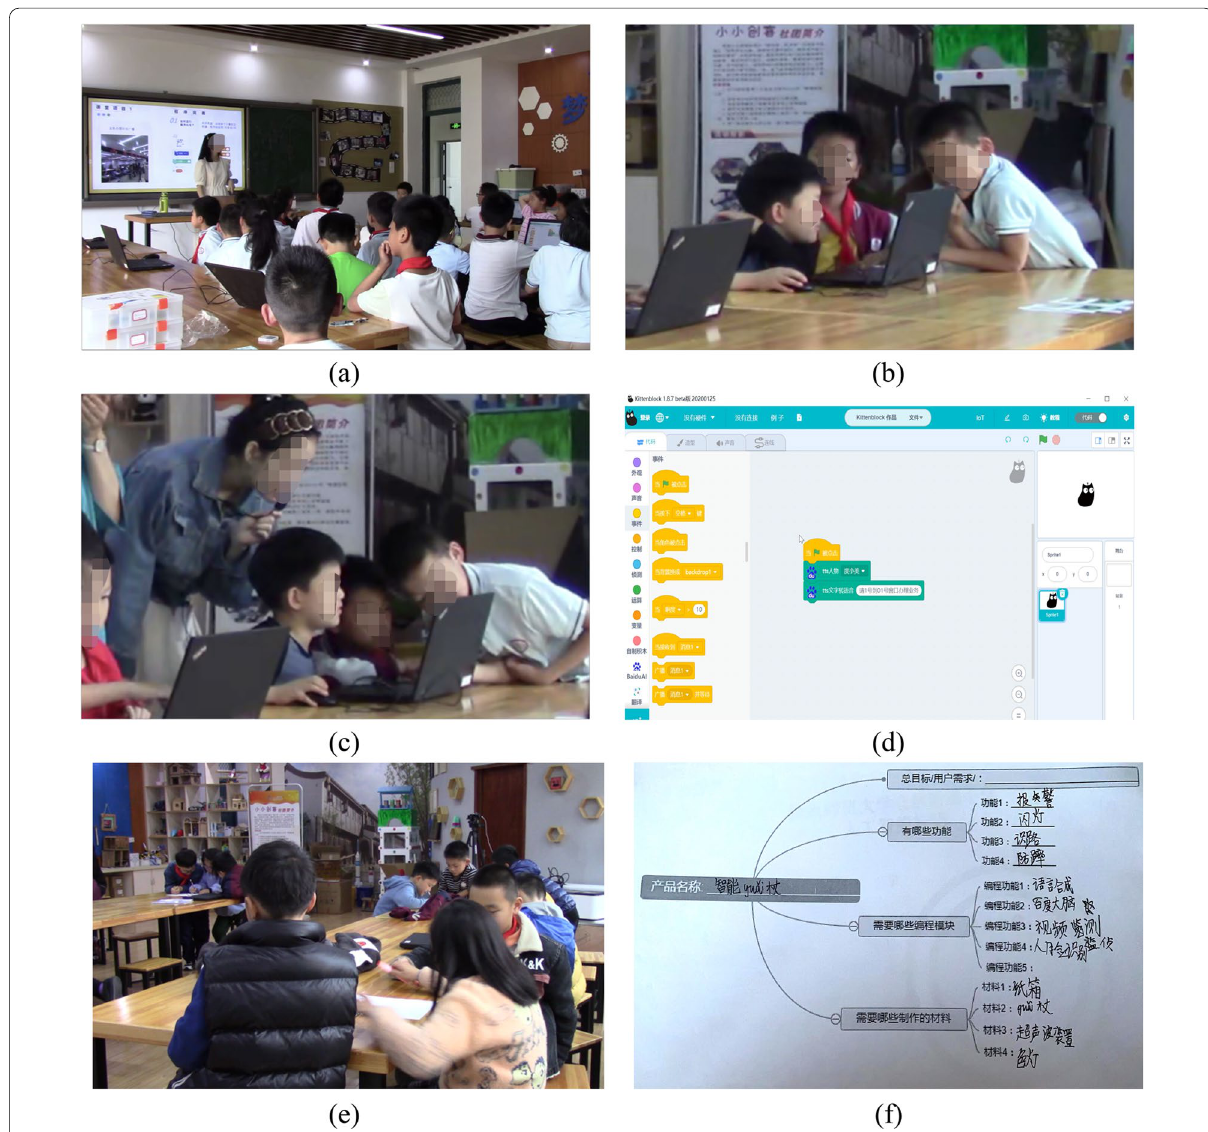
Fig. 2 In-class photos and computer screenshots. a The instructor’s lectures; b collaborative programming; c the instructor provided scaffoldings; d a screenshot of the Kittenblock software; e collaborative drawing of mind maps; and f a completed mind map by a